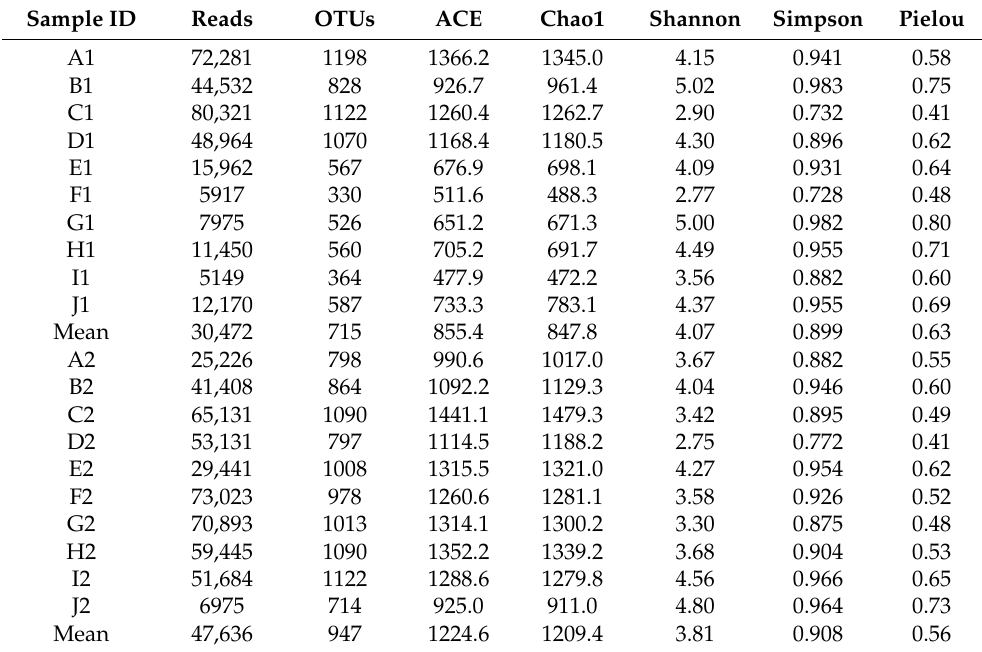
Table 1. Sequencing statistics and alpha diversity indices of eukaryotic communities among